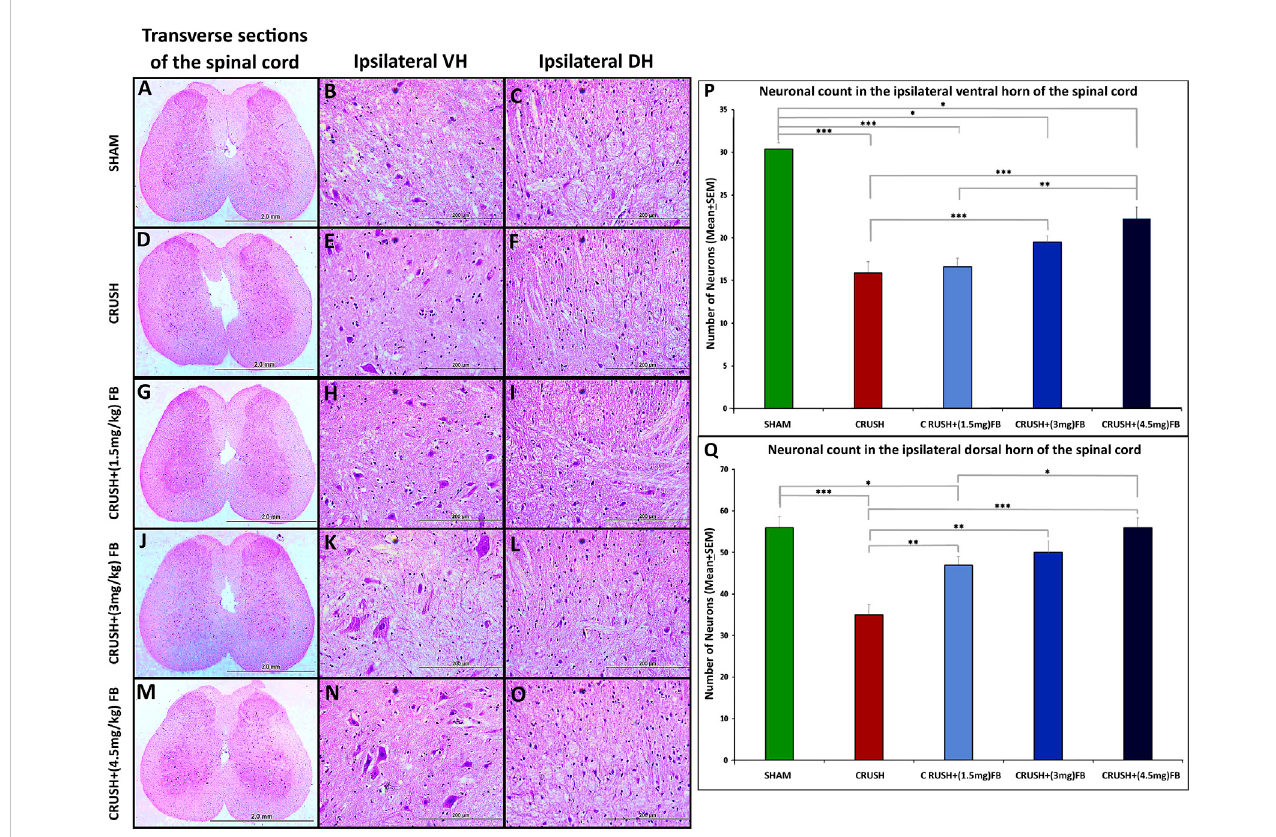
FIGURE 5 (A – O) : Representative photomicrographs (×4 and ×40 objectives) of Nissl staining of the ipsilateral ventral (VH) and dorsal horns (DH) of the lumbar spinal cord transversesection.SHAM group shows normal neurons intheipsilateralventraland dorsalhorns (B,C) .Compared to theSHAM group, theCRUSH group displays irregular neurons with eccentric nuclei (E,F) . FB-treated groups (G – O) show protected neurons compared to the CRUSH group (D – F) . (P) Statistical analysis of the mean number of ventral horn motor neurons among the fi ve experimental groups. CRUSH animals showed a reduced number ofneuronsafter sciaticnervecrushinjury.FB-treated groups displayed asigni fi cantincrease inventralhorn neuronscomparedtotheCRUSHgroup. Data are expressed as mean ± SEM. * p < 0.05, ** p < 0.01, and *** p < 0.001. (Q) Statistical analysis of the mean number of dorsal horn sensory neurons among the fi ve experimental groups. CRUSH animals showed a reduced number of neurons after sciatic nerve crush injury. FB-treated groups signi fi cantly increased dorsal horn sensory neurons compared to the CRUSH group. Data are expressed as mean ± SEM. * p < 0.05, ** p < 0.01, and *** p <